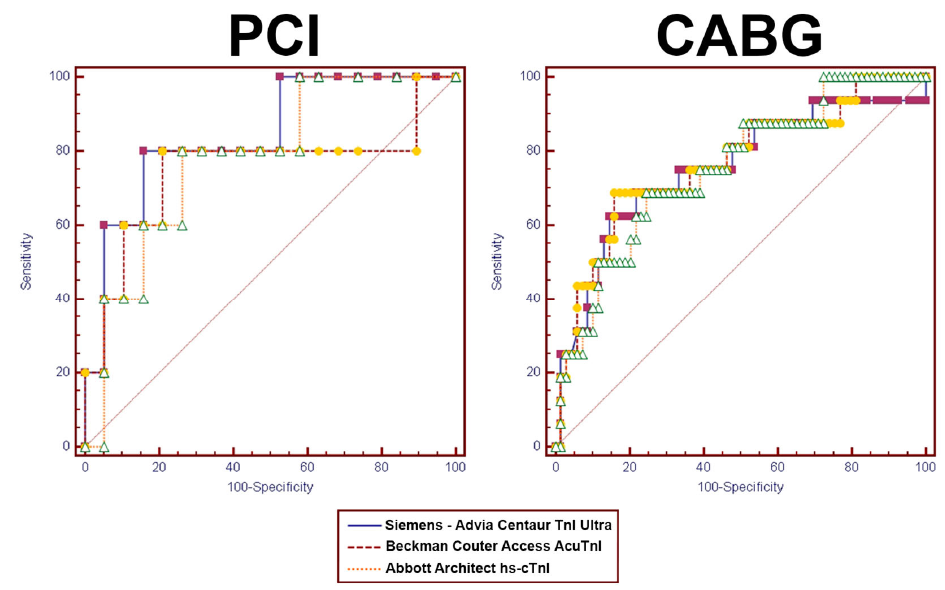
Figure 4. ROC Curves of cTnI in PCI and CABG. For CABG, all the AUCs were similar (Siemens vs. Beckman, p = 0.8079; Siemens vs. Abbot, p = 0.9773; Abbott vs. Beckman, p = 0.4683). Low accuracy of the assays for MI types 4a and 5 diagnoses was observed when the values suggested by the current guidelines for MI were used. Among the three assays, hs ‐